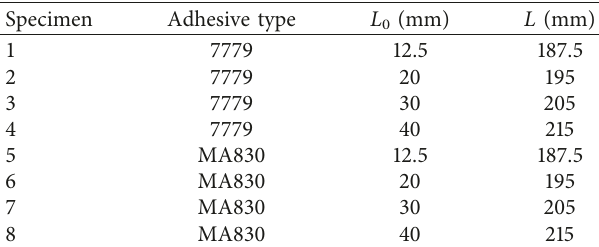
Figure 1: Schematic and dimensions of the single lap joints. Table 4: Full-factorial experimental design with corresponding factors and levels.